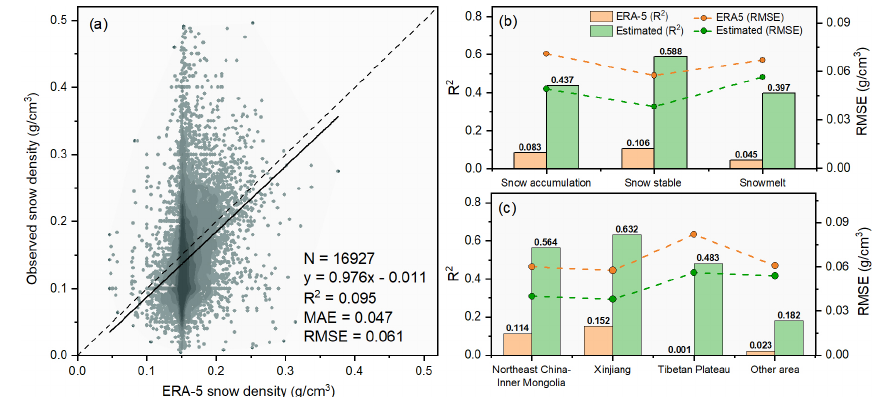
Figure 7. Accuracies of the ERA-5 snow density product in the study area (a) and the comparison of snow density estimated by the GTWNN model with that of ERA-5 in different snow periods (b) and different snow cover regions (c)